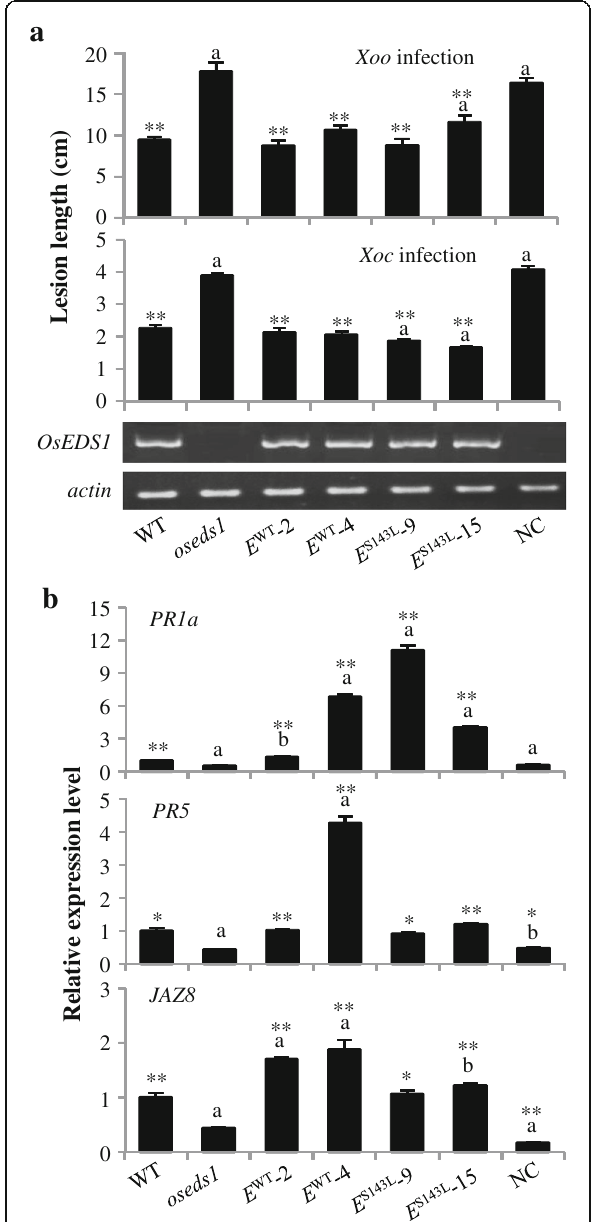
Fig. 3 Introduction of E WT and E S143L constructs complemented oseds1 mutant phenotype. Two-tail student ’ s t-test. ** and * above bar indicate significant differences compared to oseds1 at P < 0.01 and P <0.05, respectively. The “ a ” and “ b ” above bar indicate significant differences compared to wild-type (WT) at P <0.01 and P <0.05, respectively. a Introduction of E WT and E S143L to oseds1 mutant restored plants showing reduced susceptibility. Data represent mean±SE ( n = 10 to 69). b Introducing E WT and E S143L to oseds1 mutant restored PR1a , PR5 , and JAZ8 expression. Data represent mean±SE ( n